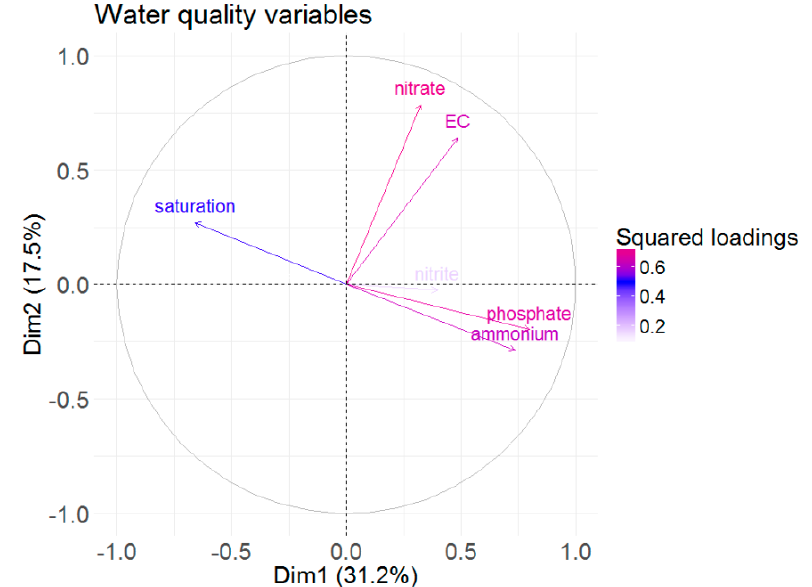
Figure 3. PCA factor map of the water quality variables. Arrows represent the squared loadings of the variables. Color intensity is proportional to the value of the loading. Variables that are closer to the correlation circle contribute more to the principal components.